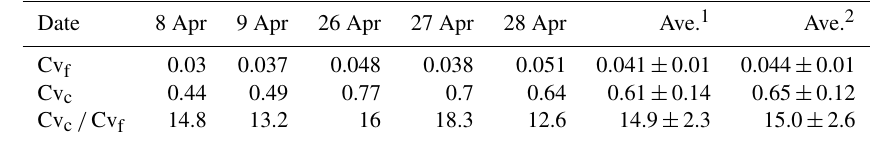
Table 4. Volume concentration of the fine (Cv f ) and the coarse (Cv c ) modes and the ratio (Cv c / Cv f ) at Dunhuang.